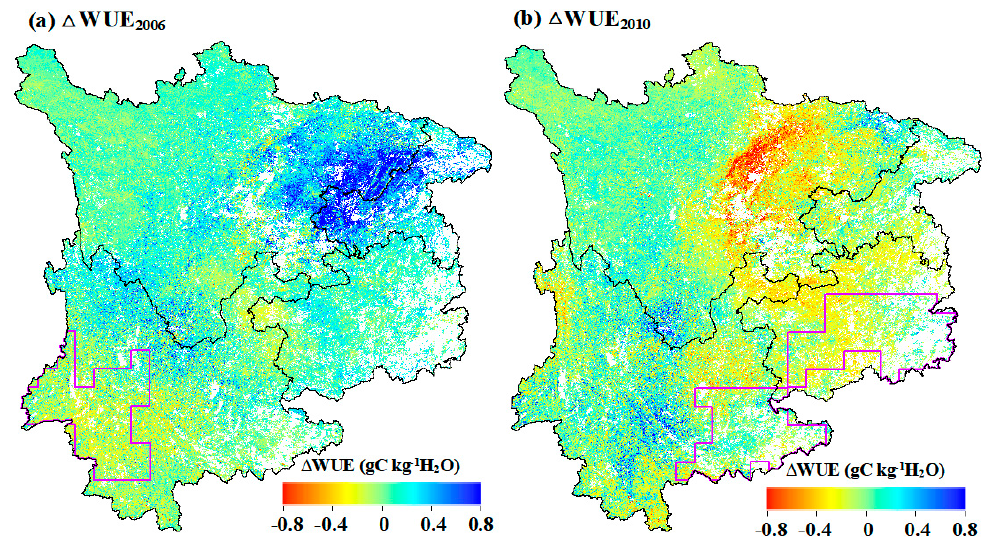
Figure 8. Magnitude and spatial patterns of annual WUE anomalies in Southwest China in 2006 ( a ) and 2010 ( b ). Severe drought areas are delineated by the purple polygons.